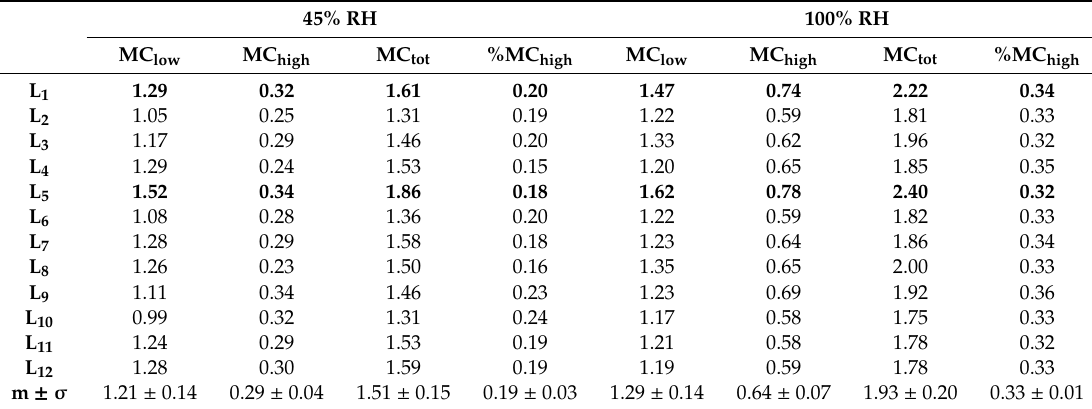
Table 1. NMR moisture contents pertaining to the low- and high-T 2 water populations (MC low and MC high ) of each L n -section. Data refer to measurements performed at 45% and 100% RH. 45% RH 100%